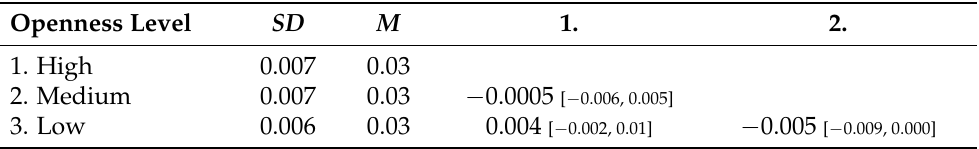
Table A20. Tukey Post Hoc Results of p − s + R statistic (SpaceShooter 2) by NEO-FFI Openness trait (see Table 2 for MANOVA results).